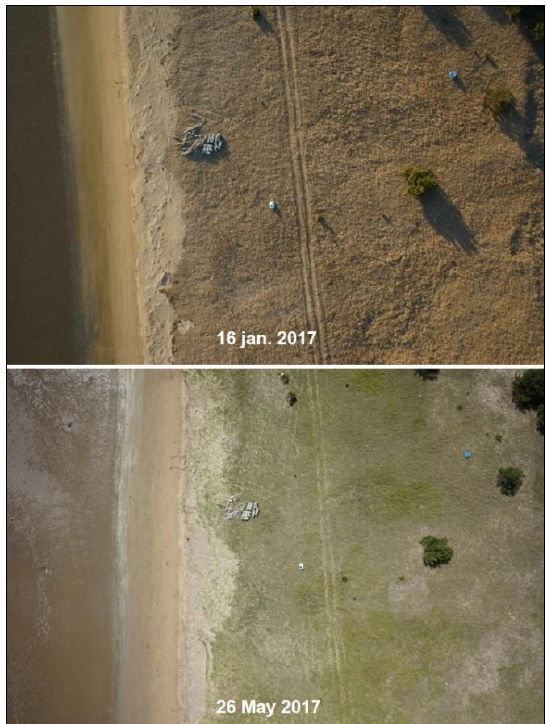
Figure 3. Aerial images acquired by M600 in Jinu-do